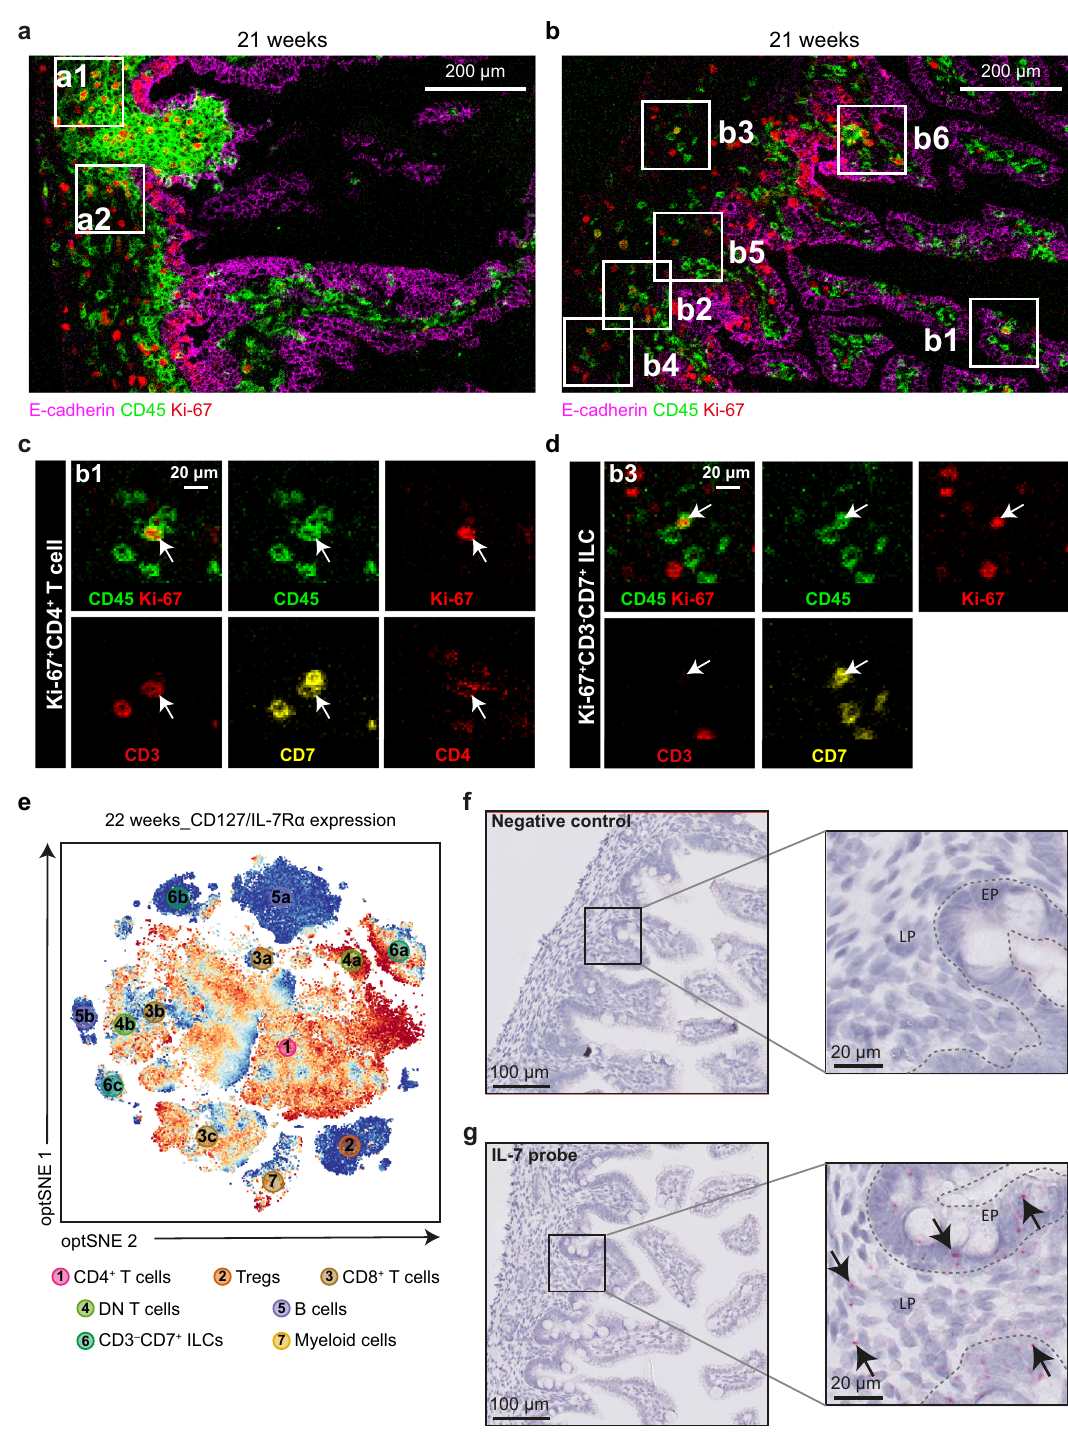
Fig. 8 | Visualization of Ki-67 and IL-7 expression in situ. a Visualization of Ki- 67 + CD45 + cellsinaLFbyoverlayofKi-67andCD45onarepresentativehumanfetal intestinalsamplefromgestationalweek21.Scalebar,200 μ m. b VisualizationofKi- 67 + CD45 + cellsin the laminapropria by overlayof Ki-67 and CD45 on anadditional humanfetalintestinalsamplefromgestationalweek21.Scalebar,200 μ m. c , d The combination of Ki-67 and immune cell markers was used to visualize (b1) Ki-